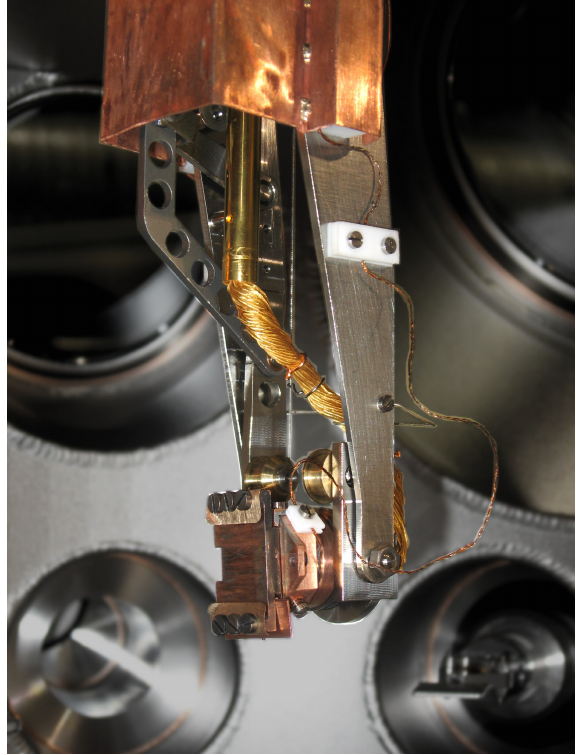
Figure 3: Cryoax 6 manipulator (designed by IFW-Dresden) adapted for the operation with Omicron- type sample